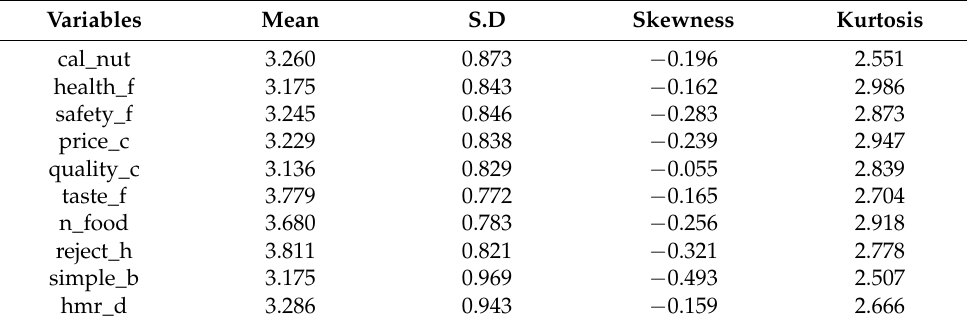
Table 4. Results of descriptive